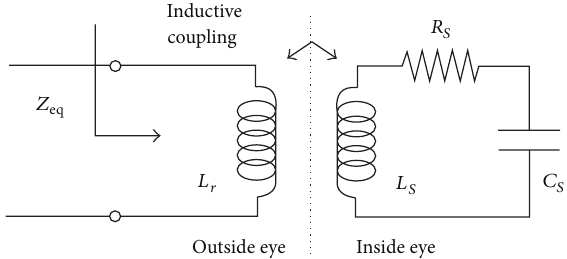
Figure 4: Equivalent circuit of an electrical model for an RLC circuit.